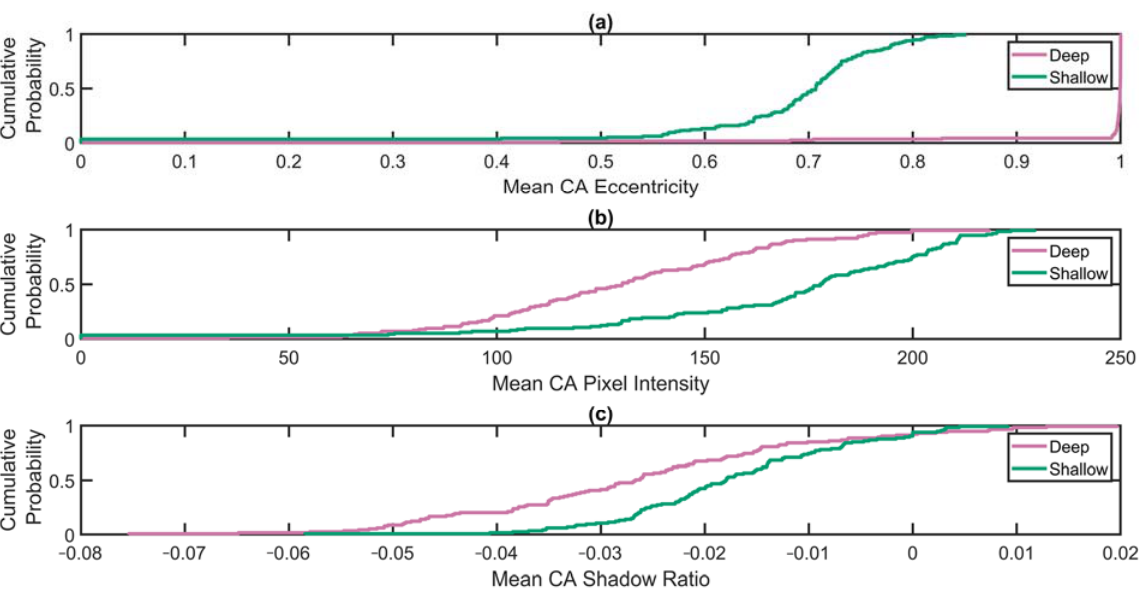
Figure 5. Empirical CDFs comparing dataset-wide (i.e., all images including testing, training, and validation subsets) variations in deep and shallow damage characteristics: ( a ) eccentricity, ( b ) pixel intensity, ( c ) shadow ratio. Shallow and deep damage CDFs are constructed using statistics from each unique damage instance (CA) across all images in the dataset, i.e., the number of CDF datapoints is equal to the number of instances of shallow and deep damage across all images.